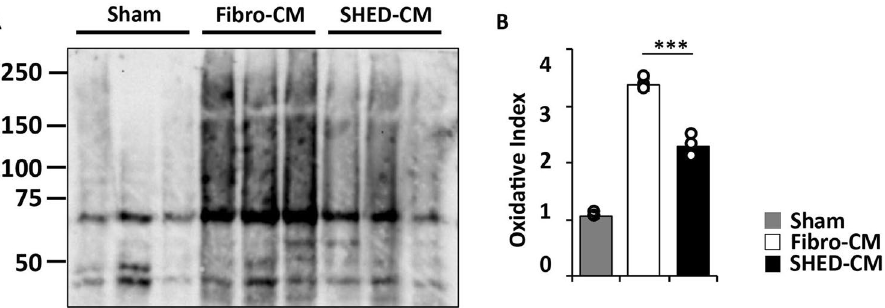
Figure 4. SHED-CM reduces the oxidative stress in irradiated mouse SG. ( A ) OxyBlot analysis of the irradiated SG 24 h after the last CM-treatment. ( B ) Quantitative analysis of the OxiBlot showing that SHED-CM significantly reduced the protein oxidation level compared to that in the Fibro-CM (n = 3). The results are expressed as oxidative indices, which were calculated as the relative densitometric values of the OxyBlot signal compared to those in the sham. Comparisons between groups were analyzed using an ANOVA with Tukey’s multiple comparison test (*** p < 0.001). CM, conditioned medium; Fibro, fibroblast; SG, salivary gland; SHED, stem cells from human exfoliated deciduous